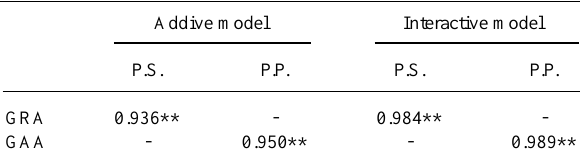
Table IX - Correlations between general reaction ability (GRA) and potential susceptibilities (P.S.) and between general aggressivity ability (GAA) and potential pathogenicities (P.P.) according to additive and interactive models. Addive model Interactive model